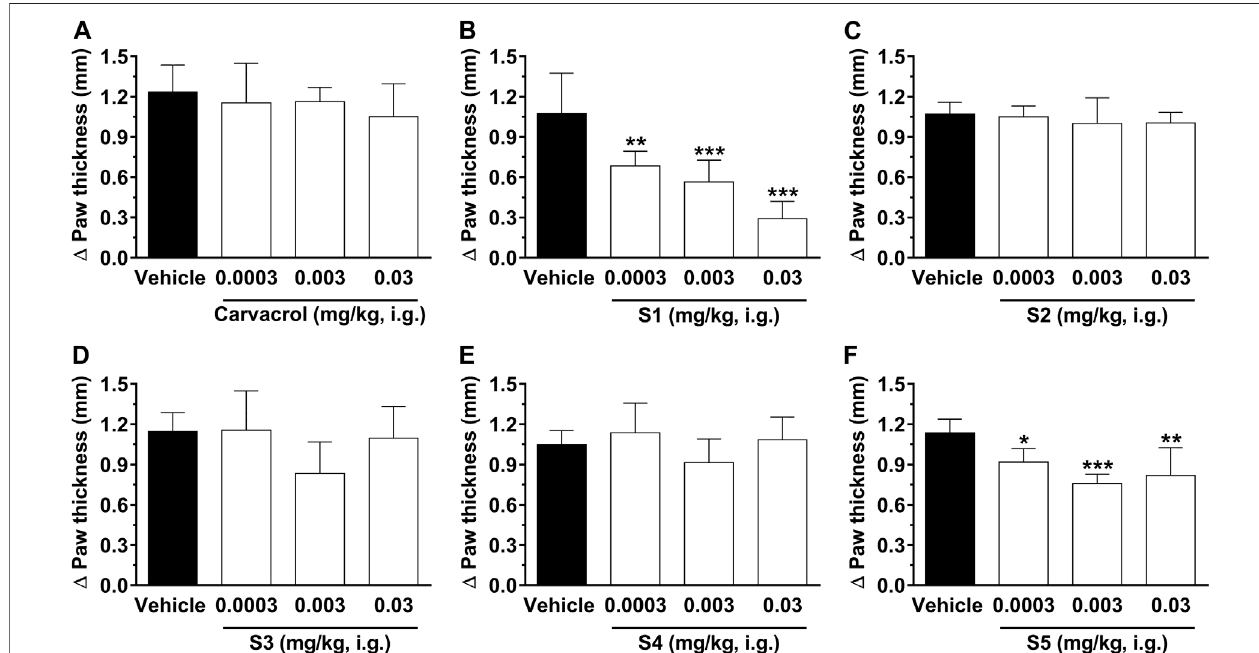
FIGURE5| Effectofcompoundsonpawedemainratsinducedbyglutamate(i.pl.). Theedemawasevaluated1houraftertreatmentwithcarvacrol (A) , S1(B) , S2 (C) , S3(D) , S4(E) and S5(F) atdosesrangingfrom0.0003,0.003,and0.03 mg/kg,i.g.,(openbars)orvehicle/control(closedbar).Theanimalpawthicknessdifference was observed before and after the glutamate test. Each bar denotes the average response for 6-8 animals, and the vertical lines represent SD. Asterisks (*) indicate the signi fi cance in comparison with the control group animals (* p < 0.05, ** p < 0.01, and *** p < 0.001). One-way ANOVA and Dunnett test for multiple comparisons were used to determine the statistical signi fi cance.